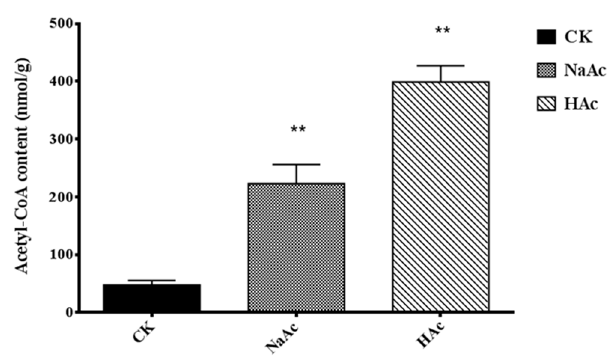
Figure 6. The acetyl-CoA content in mature fruiting bodies of Ganoderma lucidum . The error bars indicate the standard deviations from three independent samples. ** indicates statistical significance ( p < 0.01) compared to the CK strain.